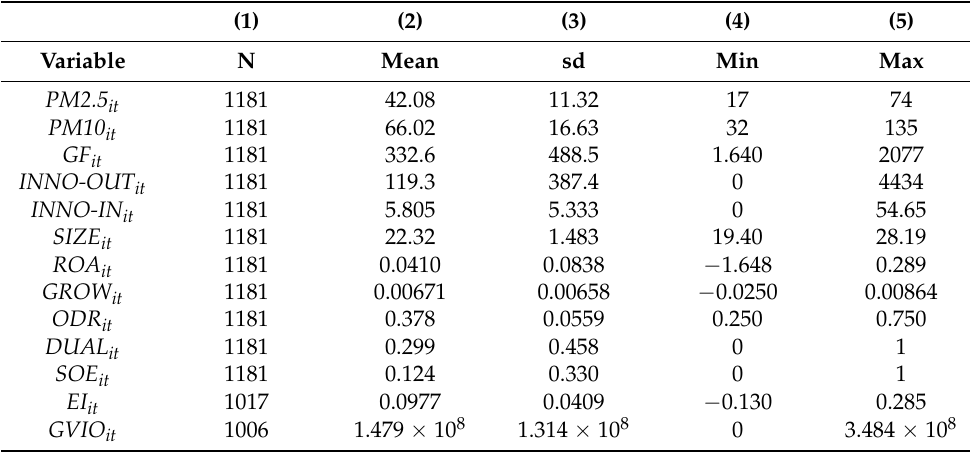
Table 2. Summary statistics of